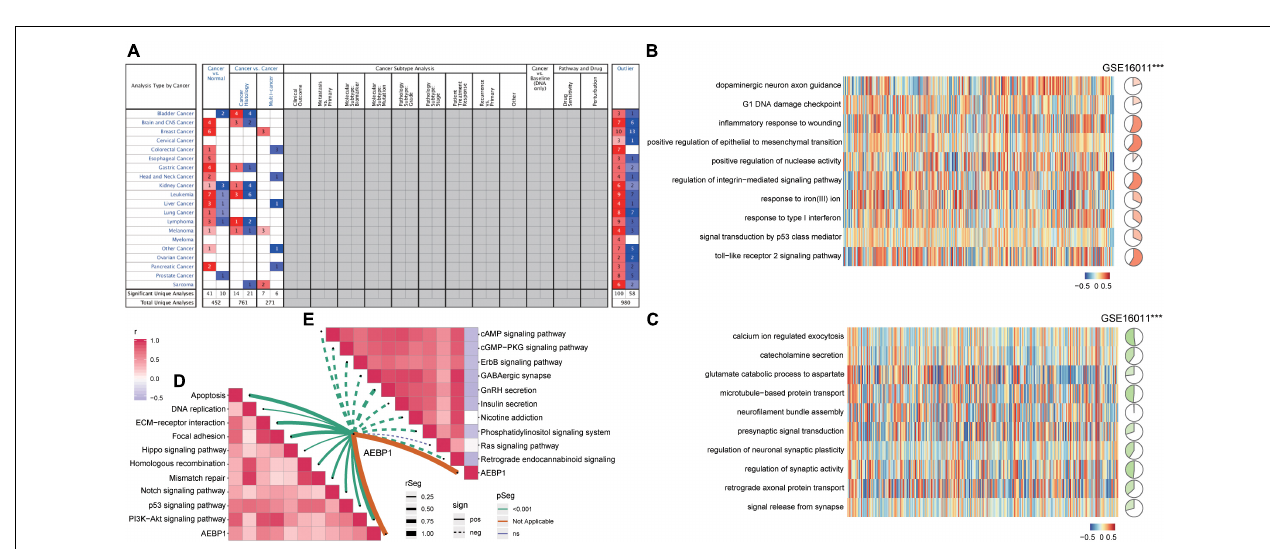
FIGURE 5 | AEBP1 may be a candidate marker for GBM. (A) AEBP1 expression in the Oncomine database. Red is high expression and blue is low expression. Numbers represent the number of analyses when the fold change of expression was 2. (B) Correlation between AEBP1 and biological processes activated in GBM. (C) Correlation between AEBP1 and biological processes inhibited in GBM. (D) Correlation between AEBP1 and KEGG pathways activated in GBM. (E) Correlation between AEBP1 and KEGG pathways inhibited in GBM.